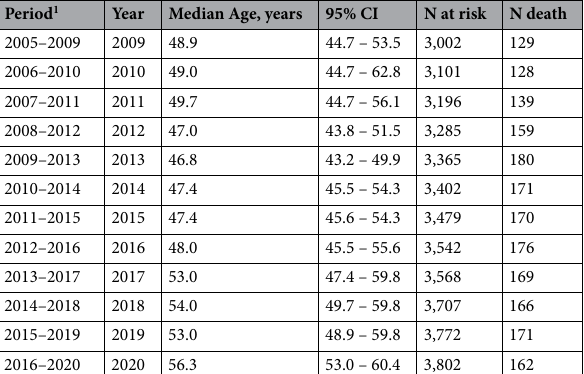
Table 3. Median survival of people with CF in Australia (2005–2020). 1 Refers to the cohort born in this period.